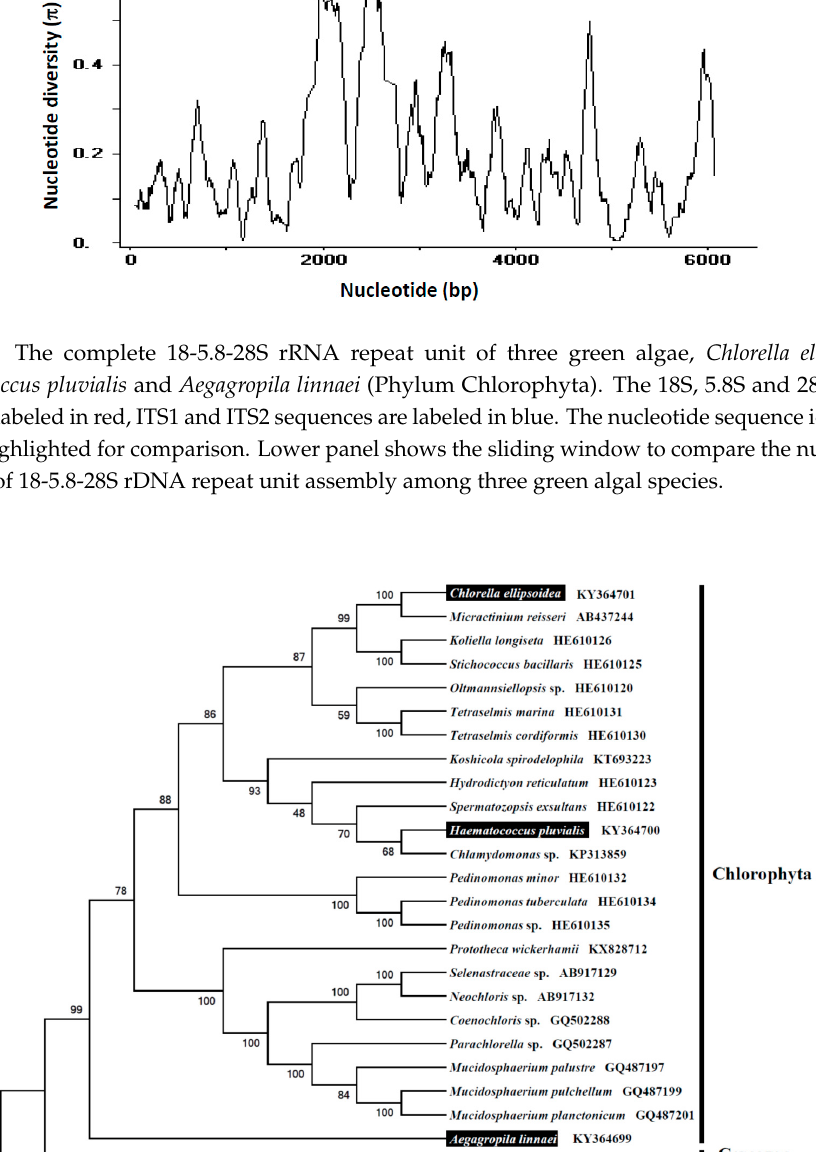
Figure 2. Molecular phylogeny of three green algae and related species in Phylum Chlorophyta based on complete 18-5.8-28S rRNA repeat units. The complete or partial 18-5.8-28S rRNA repeat sequences were downloaded from GenBank to construct a phylogenic tree by the Maximum likelihood method with 500 bootstrap replicates. Three targeted green algal Chlorella ellipsoidea , Haematococcus pluvialis and Aegagropila linnaei , are highlighted in black.